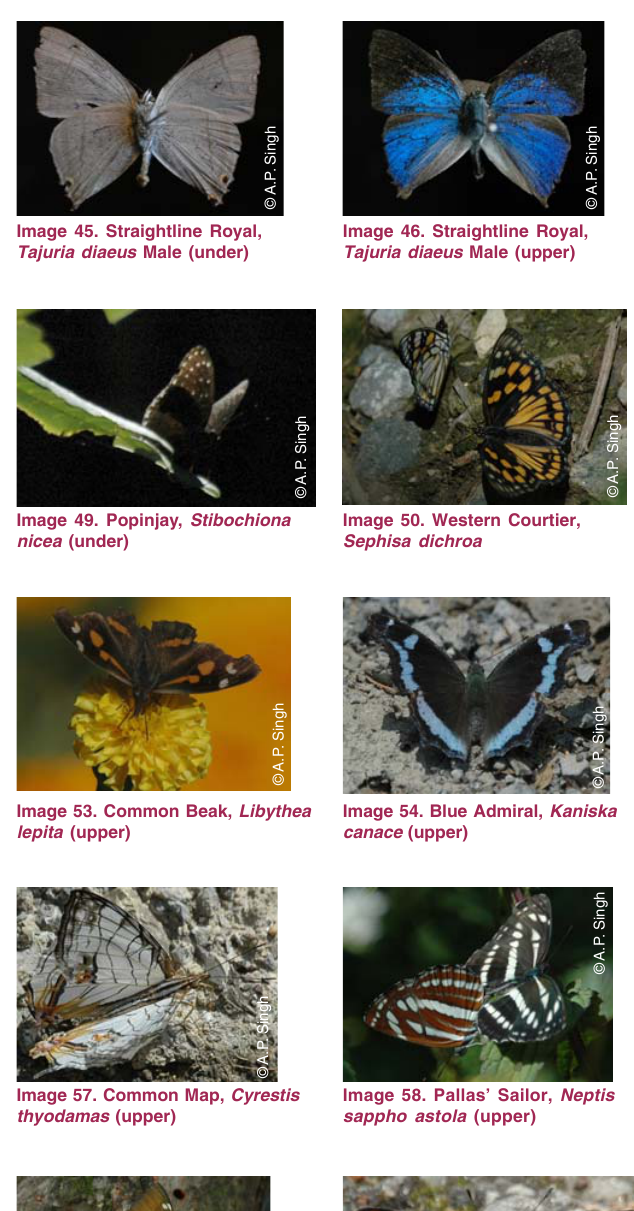
Image 56. Common Jester, Symbrenthia lilaea (under)